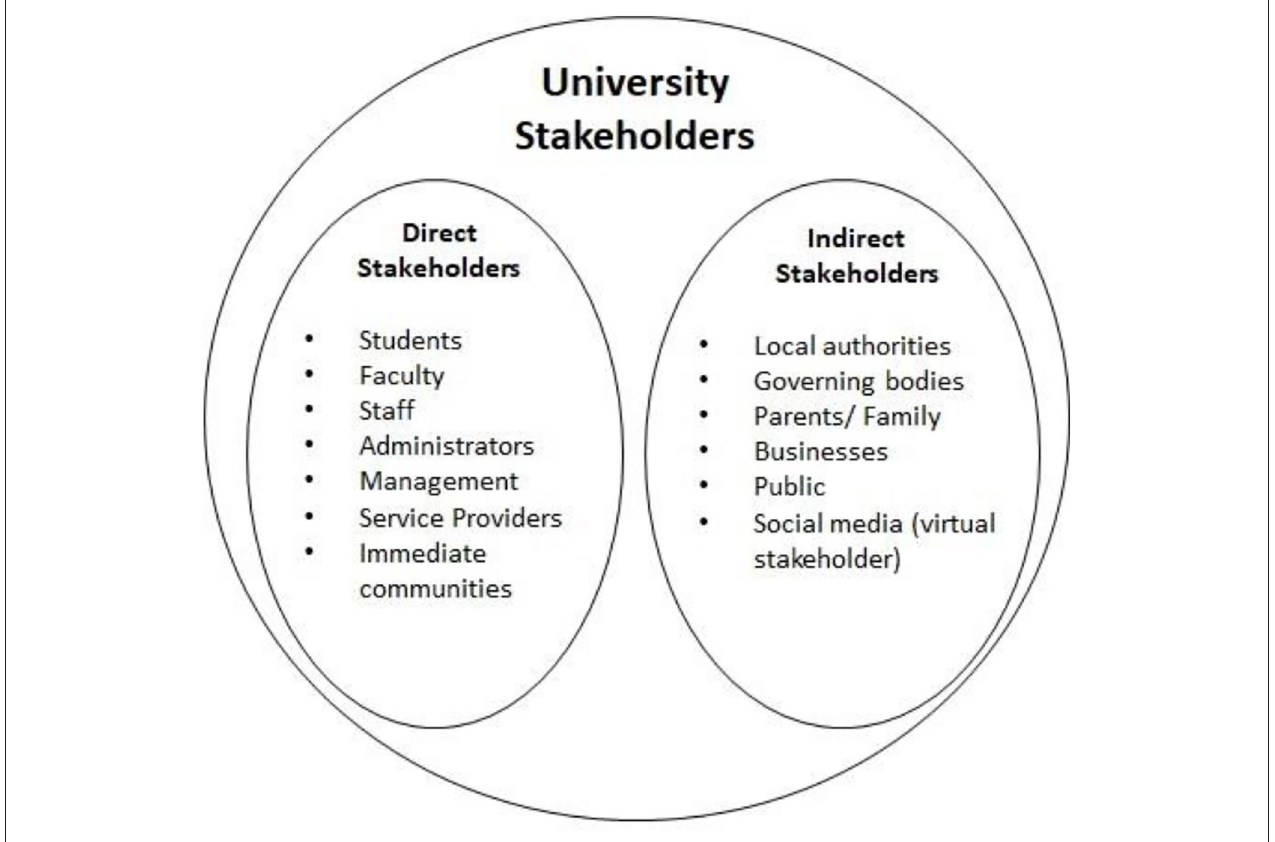
FIGURE 3 | Typical stakeholders in a